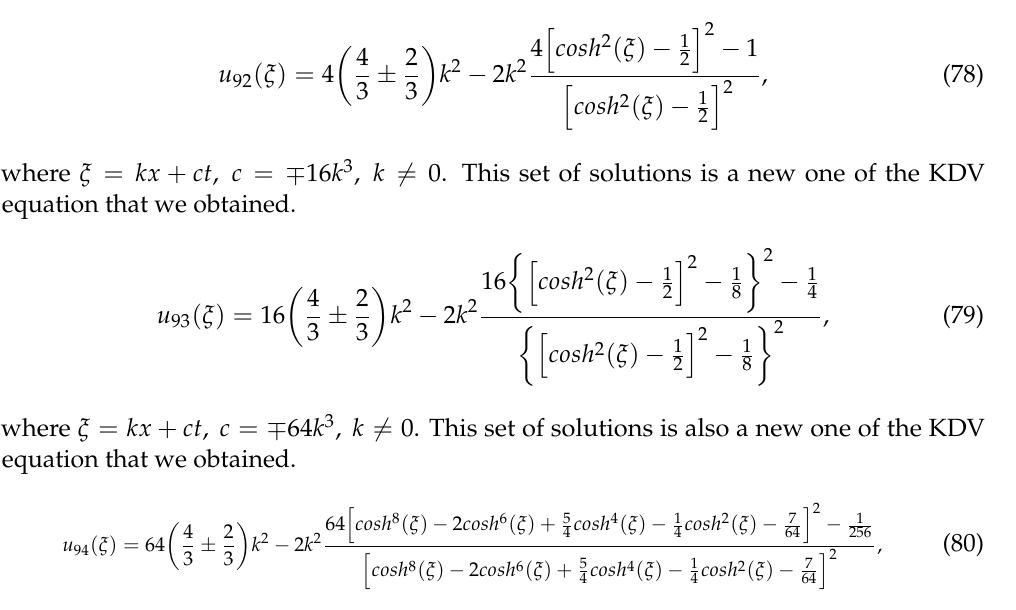
15 of 18 Figure 8. Evolution of solitary waves with n in 𝑢 (cid:2876)(cid:3041) when 𝑘 = 1 : ( a ) 𝑛 = 1 , ( b ) 𝑛 = 2 , ( c ) 𝑛 = 3 , and ( d ) 𝑛 = 4 .